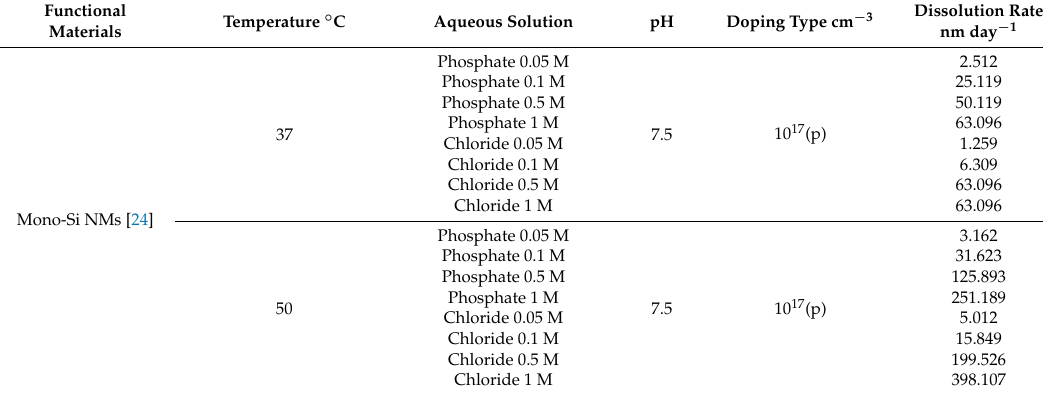
Table 2. The dissolution behavior of silicon nanomembranes (Si NMs) under different conditions